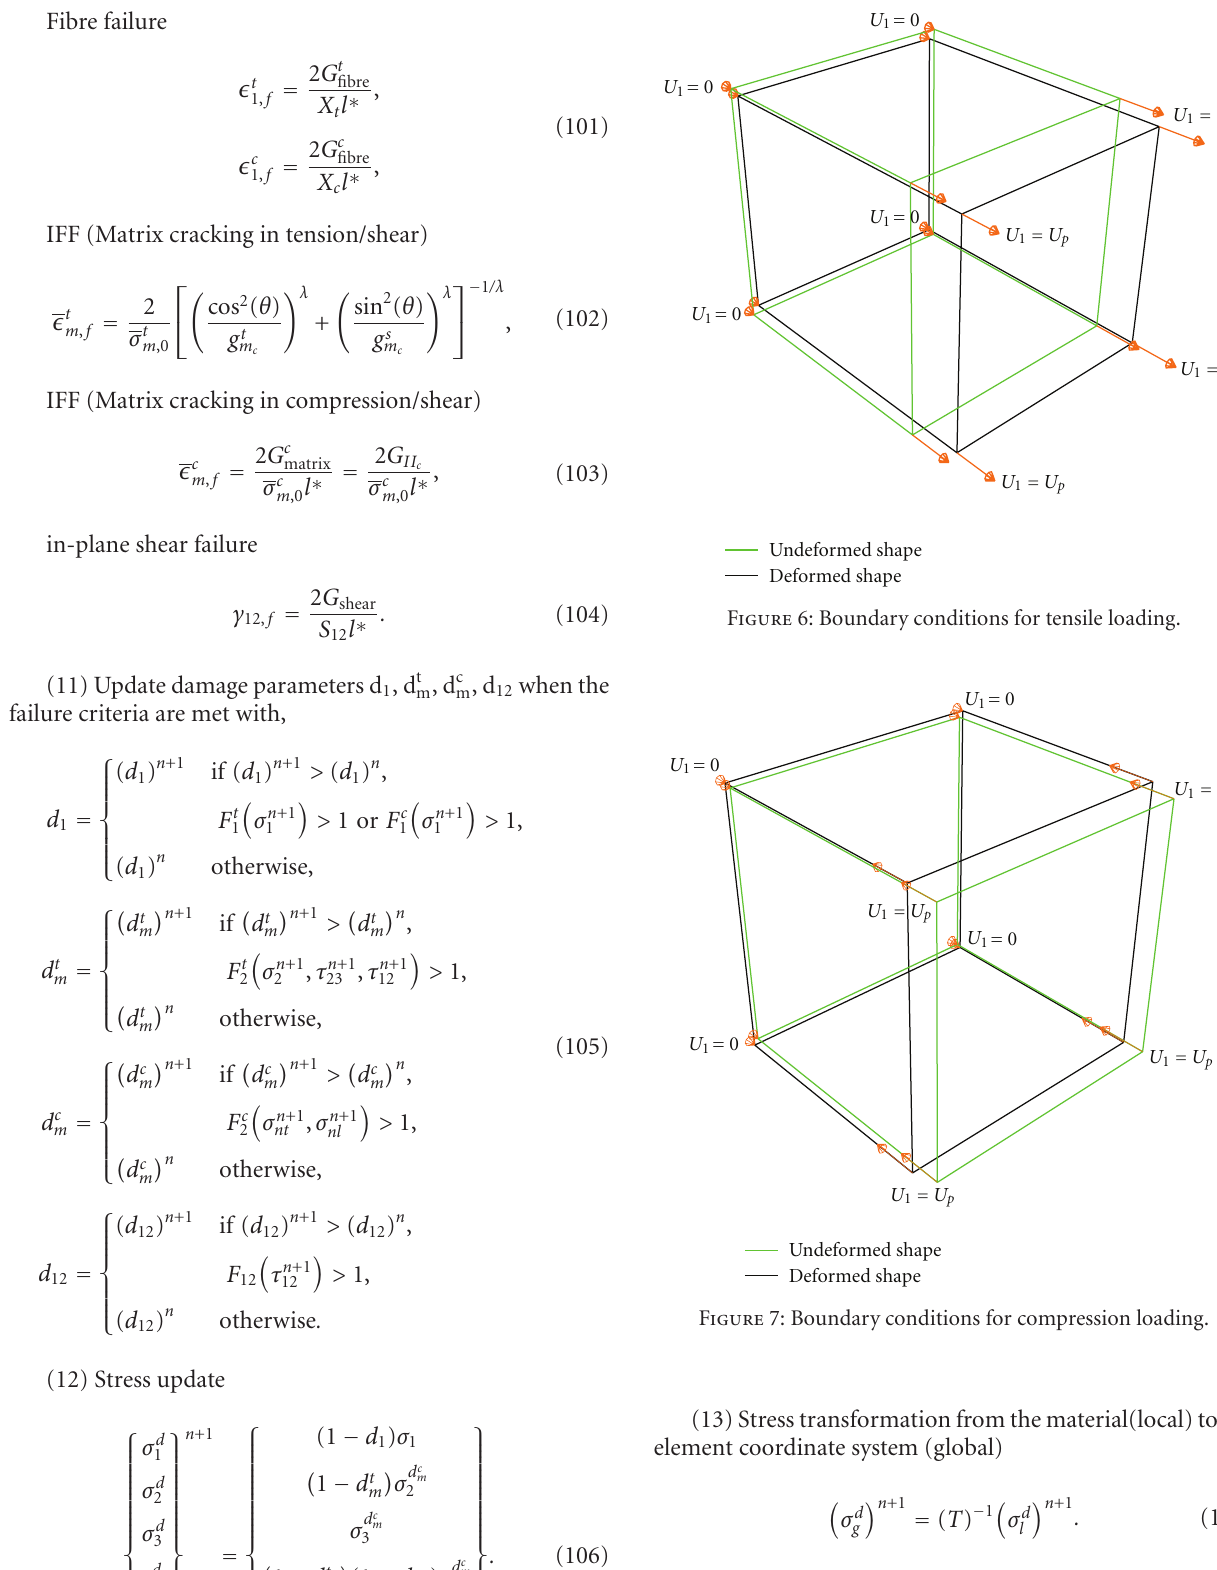
(14) Compute element nodal forces, add element hour- glass control nodal forces, transform element nodal forces to global coordinates, solve for accelerations via equation of motion and update velocities and